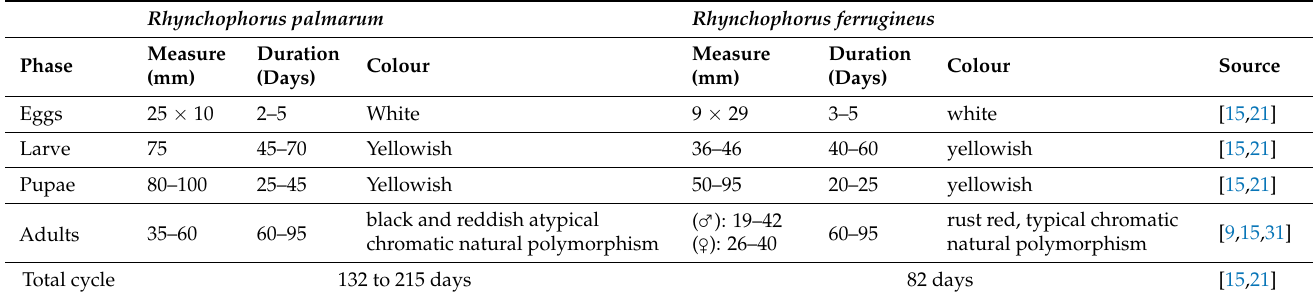
Table 1. Rhynchophorus palmarum and Rhynchophorus ferrugineus quick